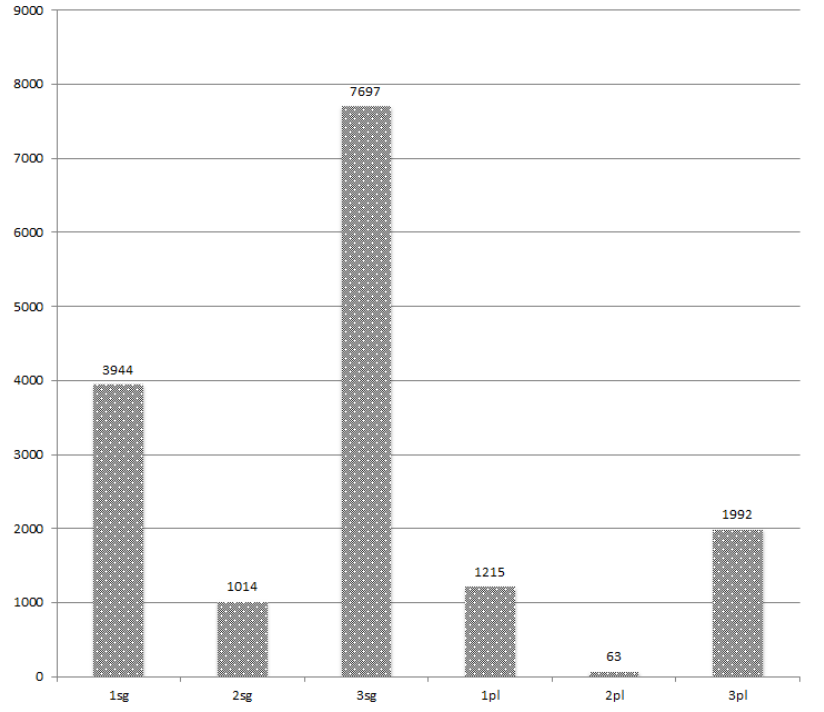
Figure 5. Haber dicho and grammatical person in the